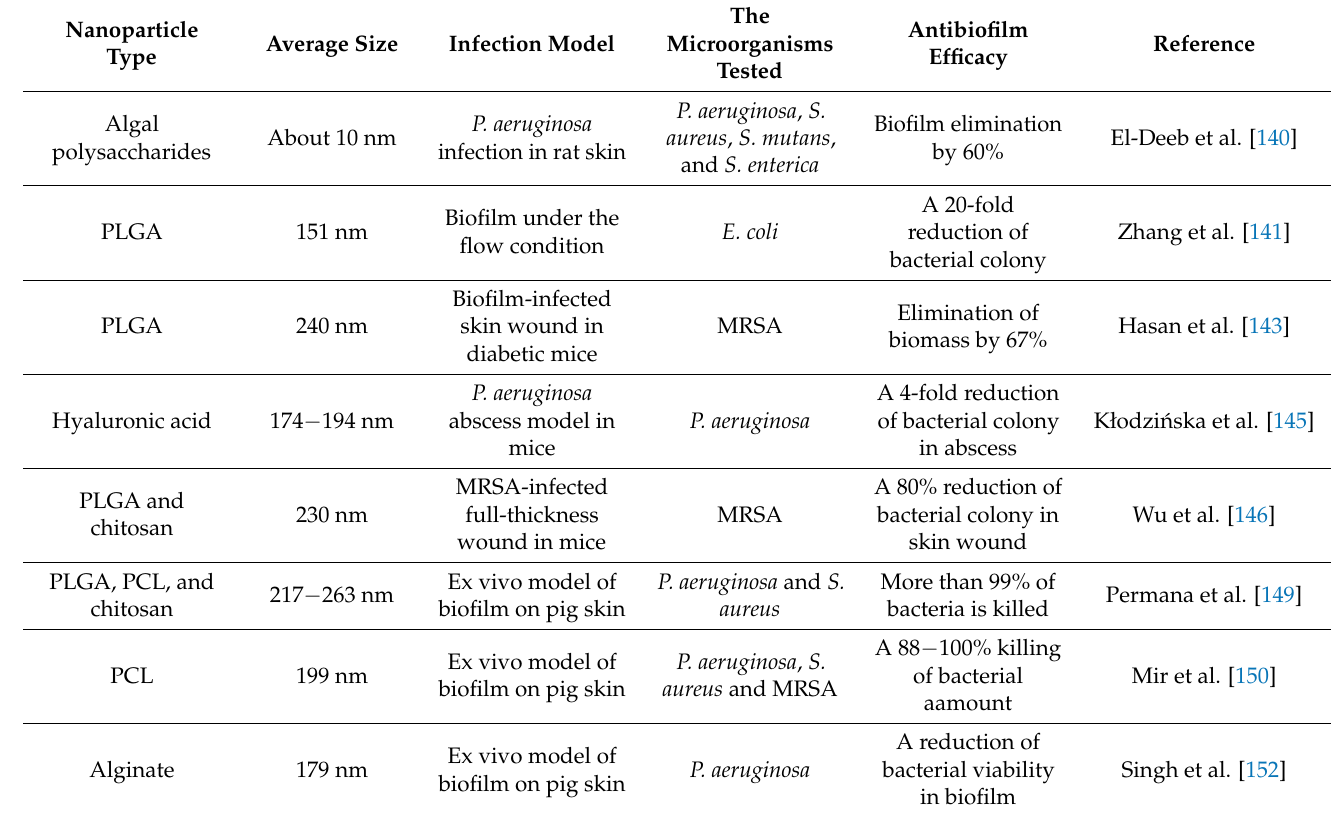
Table 3. The application of polymeric nanoparticles for antibiofilm